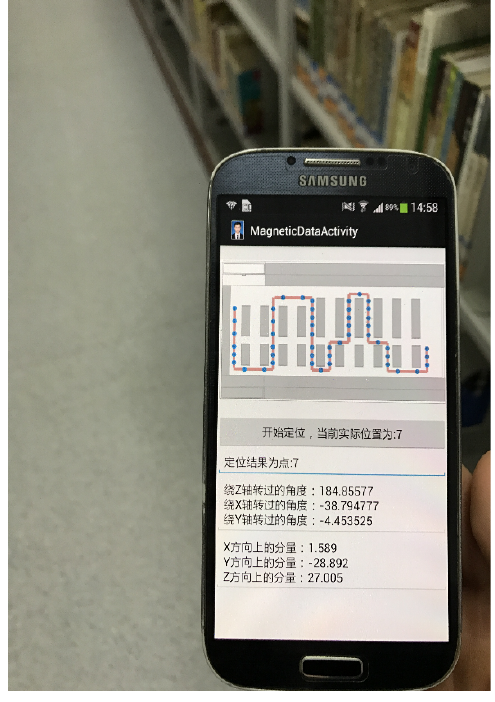
Figure7 Positioning experiment